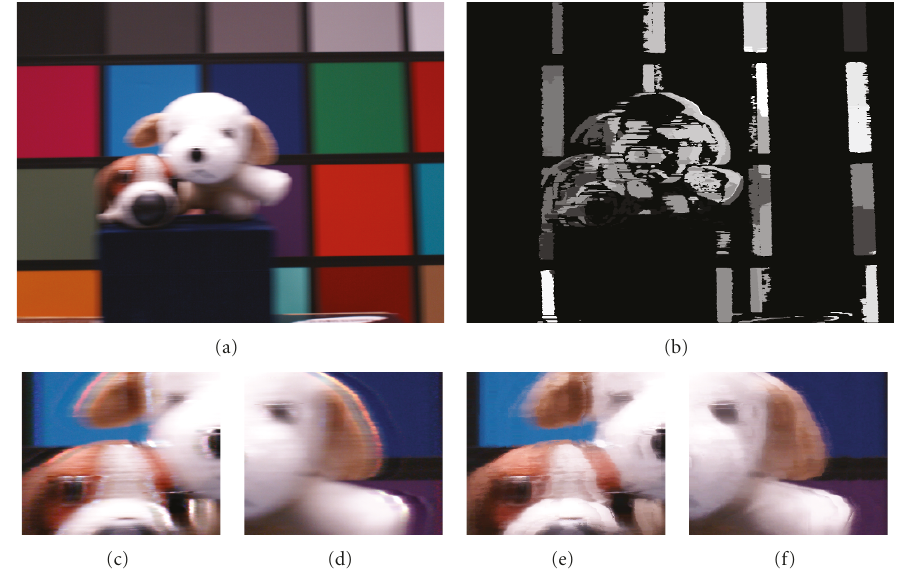
Figure 16: Comparison of restoration results on Doll image. (a) Blurred image. (b) Segmentation result. (c)-(d) Magnified region of the deblurred image obtained by [7]. (e)-(f) Magnified region of the deblurred image obtained by the proposed